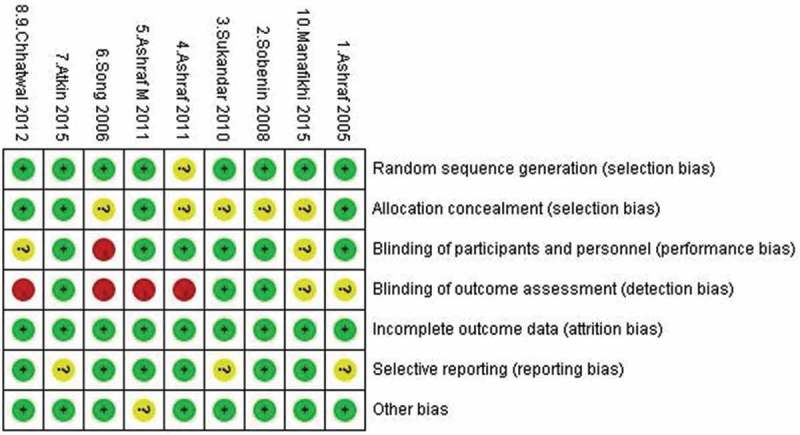
Quality assessment of the included trials.